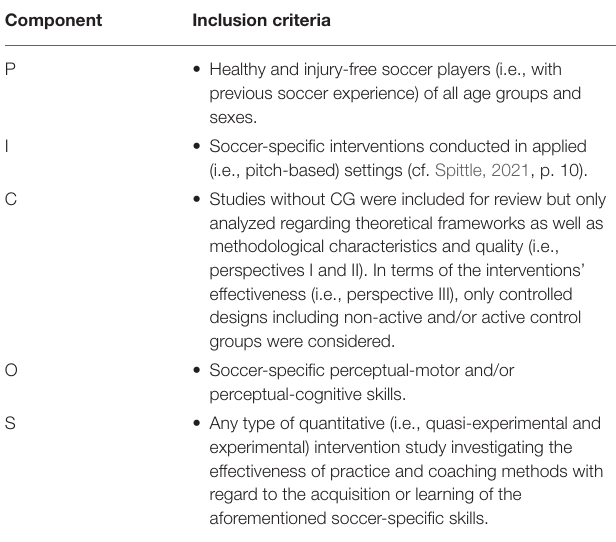
TABLE 1 | Specification of inclusion criteria regarding the components participants, interventions, comparators, outcomes, and study designs (PICOS).